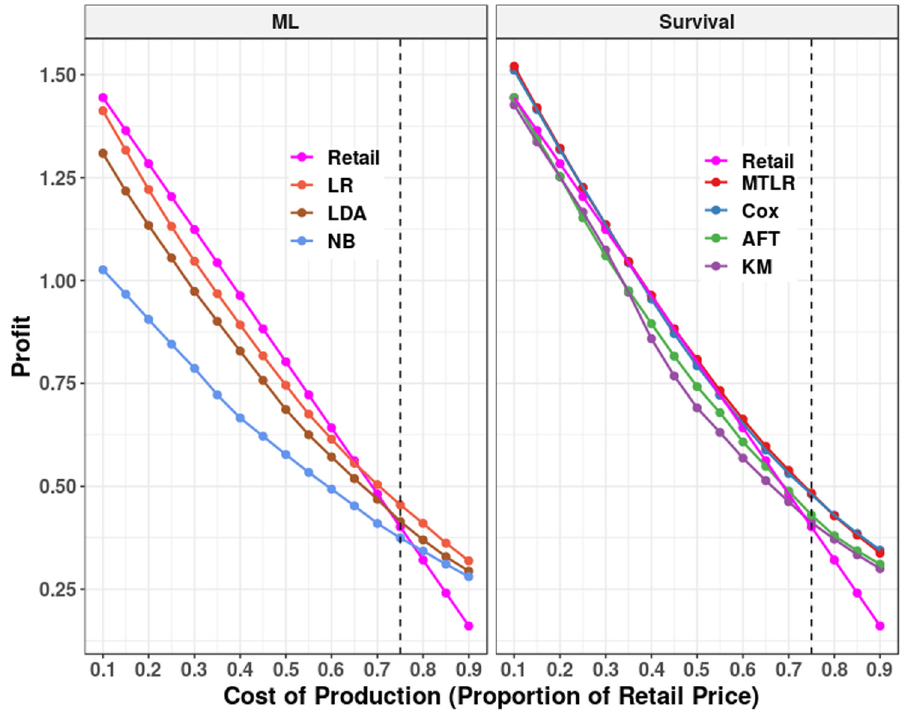
Fig 11. Overall average profit 10-times 10-fold cross validation results. On left, the average profit generated by the ML models– i.e. , LR, LDA, and NB. On right, the average profit for the survival models– i.e. , KM, AFT, Cox, and MTLR. The retail price model (in pink) is included in both sections for reference. The vertical dashed line is placed at the most likely real proportion of cost (0.75). See details in Table 8 in S1 File.